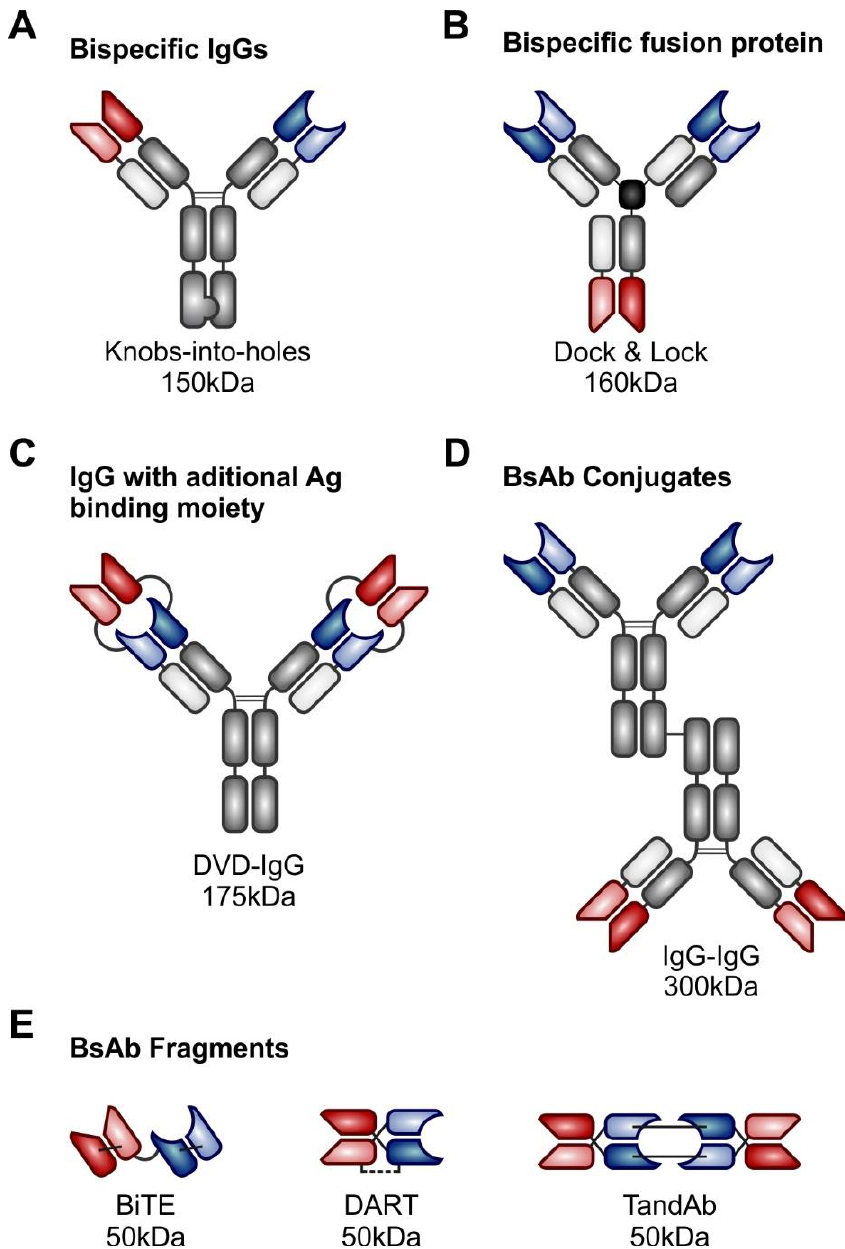
Figure 2. Alternative bispecific antibody formats in clinical development. Legend: ( A ) immunoglobulin gamma (IgG)-like bispecific antibody (bsAb); ( B ) bispecific fusion protein; ( C ) IgG with additional antigen binding moiety; ( D ) bsAb conjugates; ( E ) bsAb fragments including bispecific T-cell engagers (BiTE), dual-affinity re-targeting antibody (DART), and tandem diabody (TandAb). Dark and light colours represent heavy and light chains, respectively; blue and red colours represent variable fragments specific for different antigens.